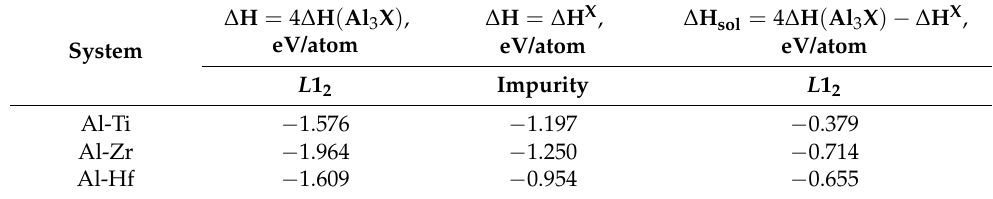
Table 2. Mixing enthalpy of Al 3 X (X = Ti, Zr, Hf) compounds and TM